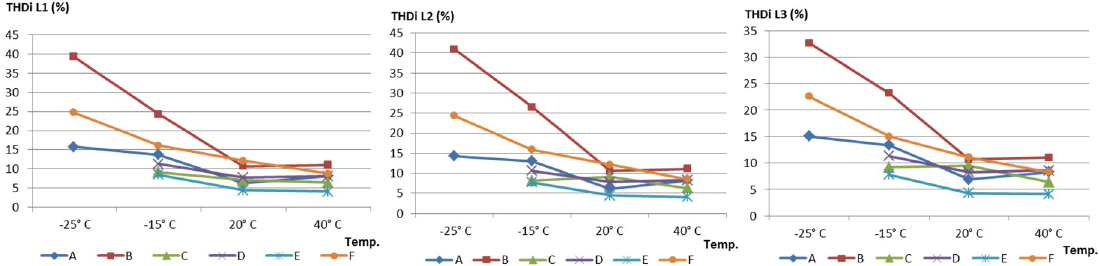
Figure 2. Current total harmonic distortion variation, with temperature per phase.